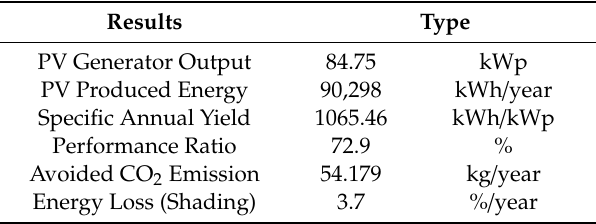
Figure 11. System array model. Table 7. The PV*SOL Output Results.